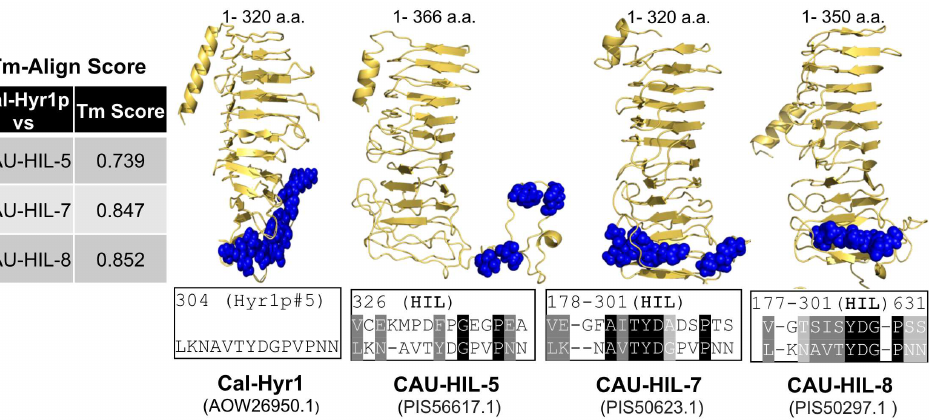
Figure 2. Cal-Hyr1 shows high structural similarity with Hyr1/Iff-like proteins (HIL) of C. auris . Cal-Hyr1 was used to blast search similar proteins in C. auris . Top hits that also contain high sequence identity with Cal-Hyr1 antigenic peptide#5 epitope were selected to generate a 3D model using the iTasser server. Protein models containing cell surface-exposed N-terminal regions of each protein were aligned against the Cal-Hyr1p model and Tm alignment scores were generated (Table). A Tm score of >0.5 indicates proteins with similar folding. Cal-Hyr1p peptide#5 homologous regions are visualized with blue spheres. Sequence homology between Cal-Hyr1 peptide#5 and C. auris HIL proteins is shown under each model.